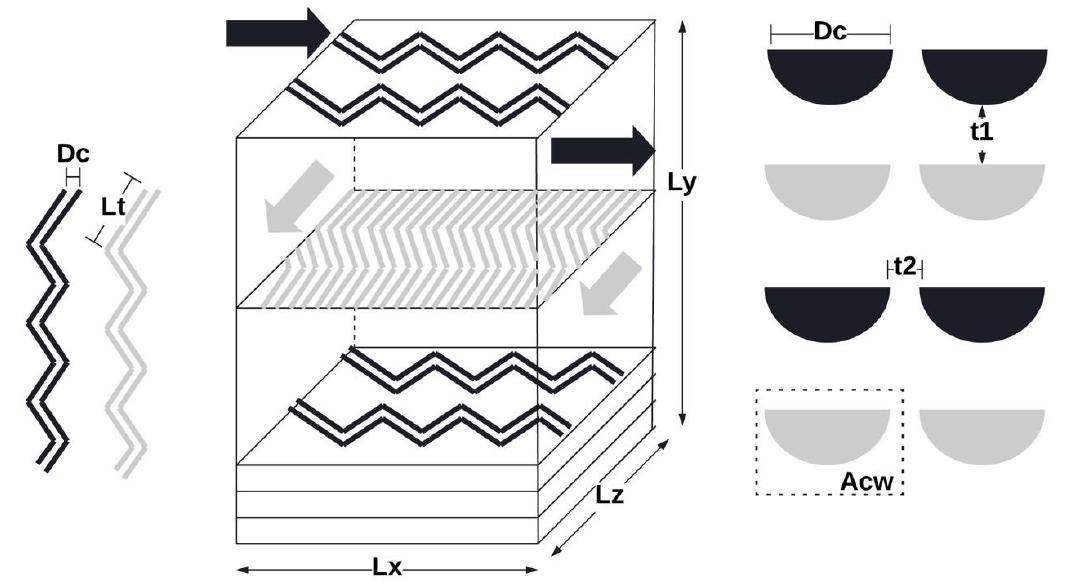
Figure 4. Printed circuit heat exchangers geometrical design.